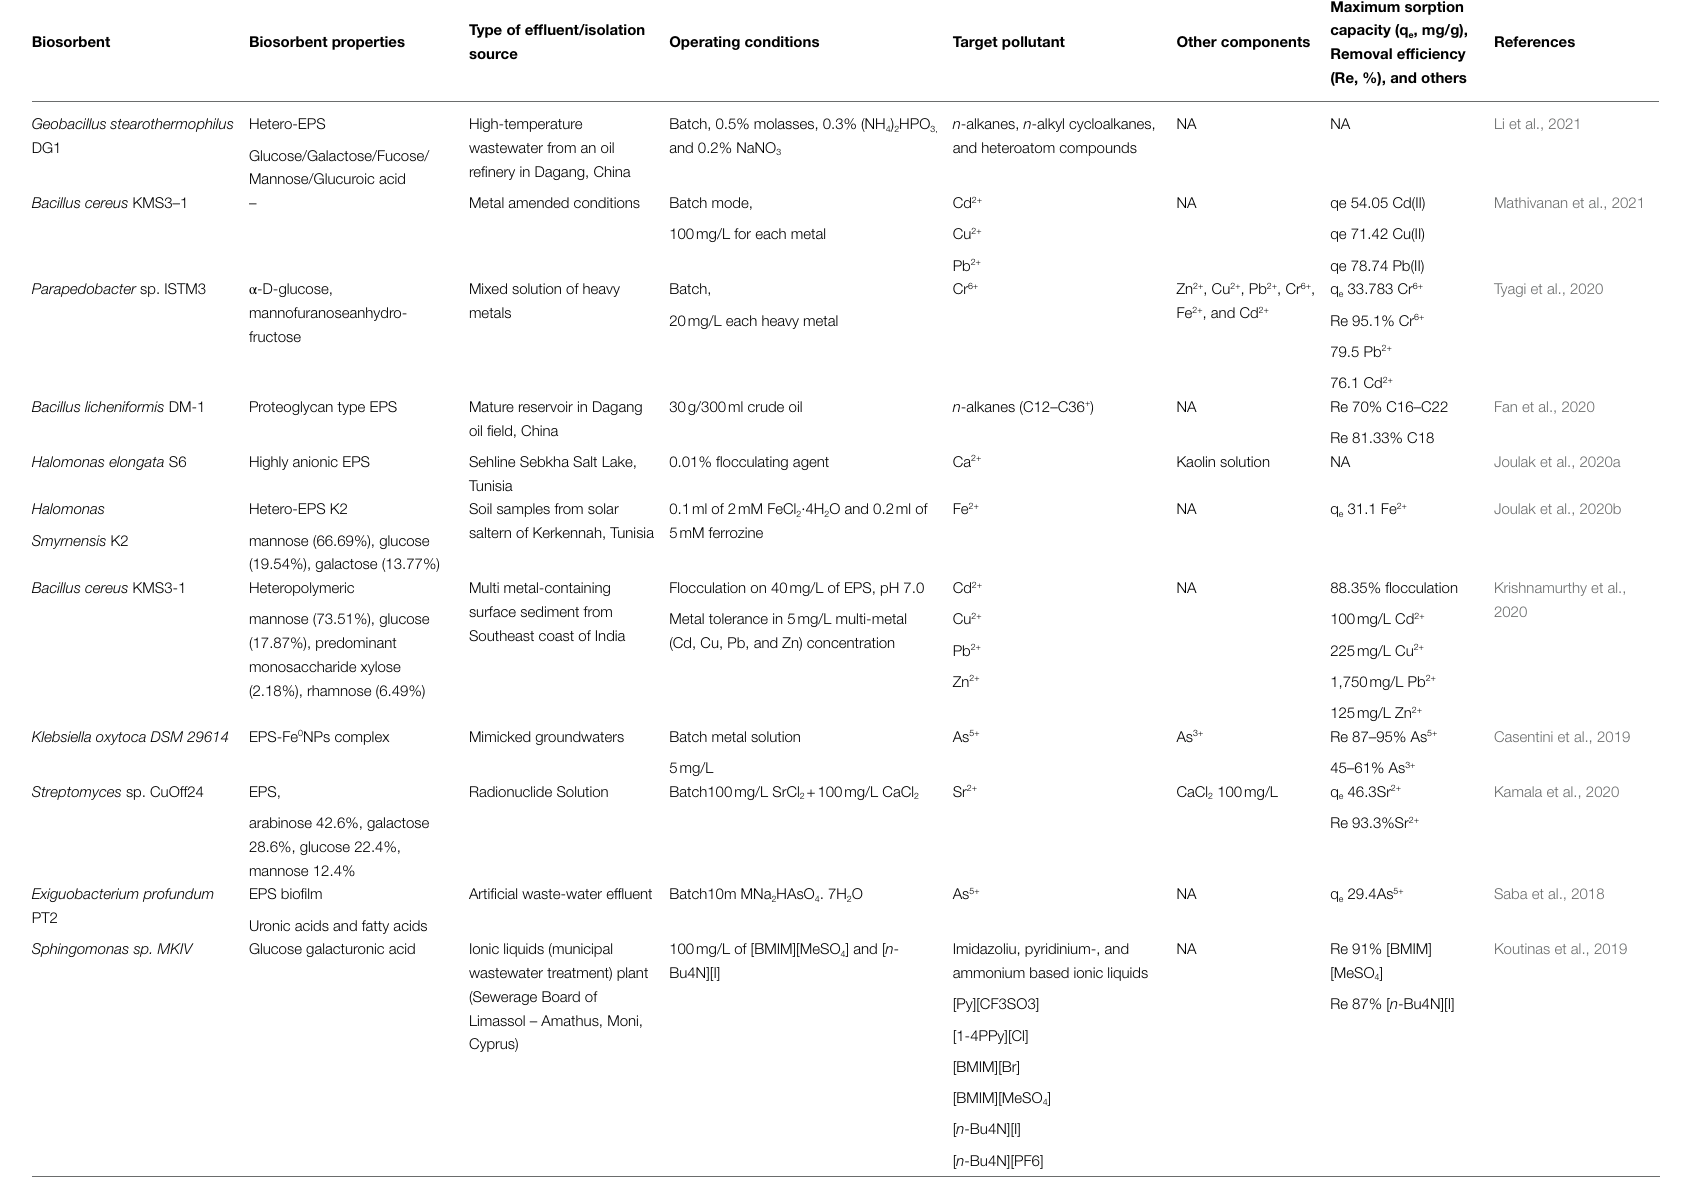
TABLE 1 | Main sources and characteristics of EPS produced by extremophilic bacteria in wastewater treatment-related processes in last 5 years.